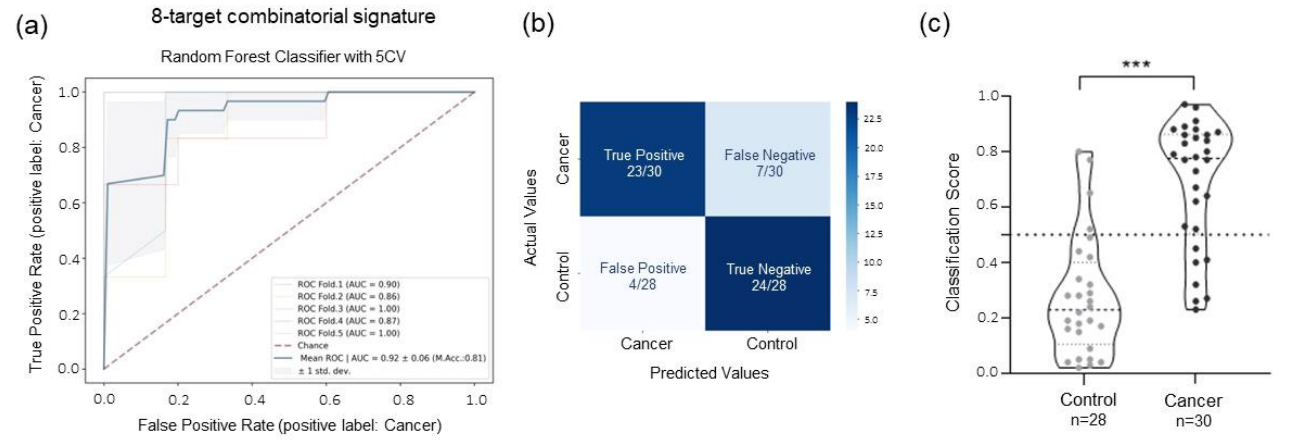
Figure 6. ML analysis using combinatorial signature of mRNA and circRNA. ( a ) AUC ROC curve of the 8-mRNA-circRNA signature using RF classifier for group classification. ( b ) Confusion matrix indicating the number of the correctly classified and misclassified samples based on the previous prediction model. ( c ) Violin plot of the classification score per samples generated using the 8-mRNA-circRNA predictive model (*** indicates p -value < 0.001 in a two-tailored Mann–Whitney U test).